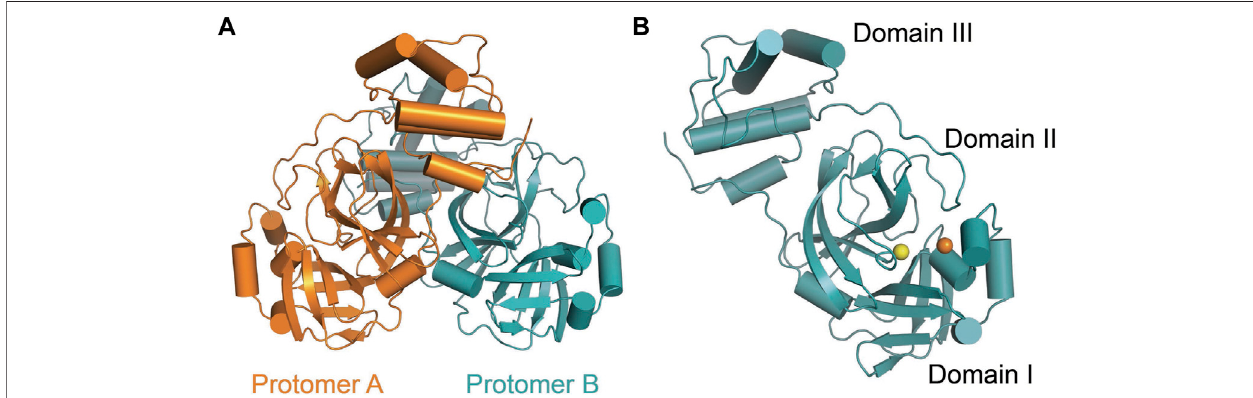
FIGURE8| Three-dimensional structure ofSARS-CoV-2Mpro. (A) Oneprotomerofthedimer isshowninorange, and theotheroneisshown inteal(PDB:6LU7). (B) Cartoon representation of the crystal structure of one protomer. The amino acid residues of the catalytic site are indicated as yellow sphere for Cys145 and orange sphere for